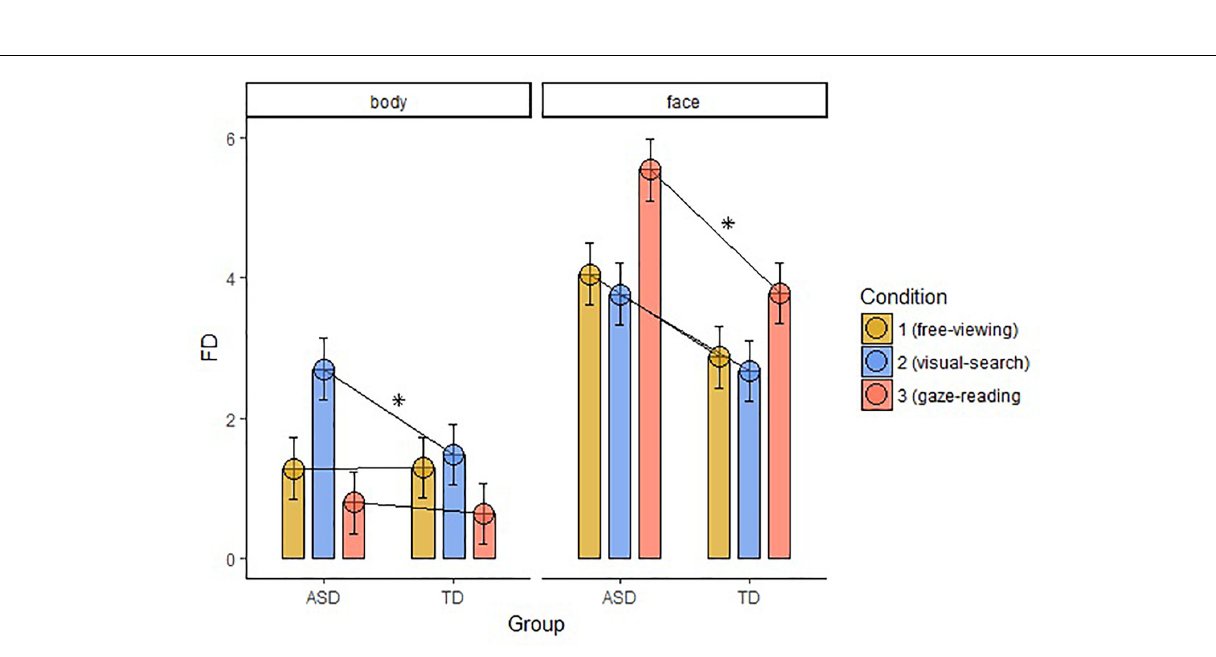
FIGURE 4 | Average FD within the two groups of AOIs, body and face, across groups and conditions (FD, fixation duration; ASD, autism spectrum disorder; TD, typical development; ∗ , significant